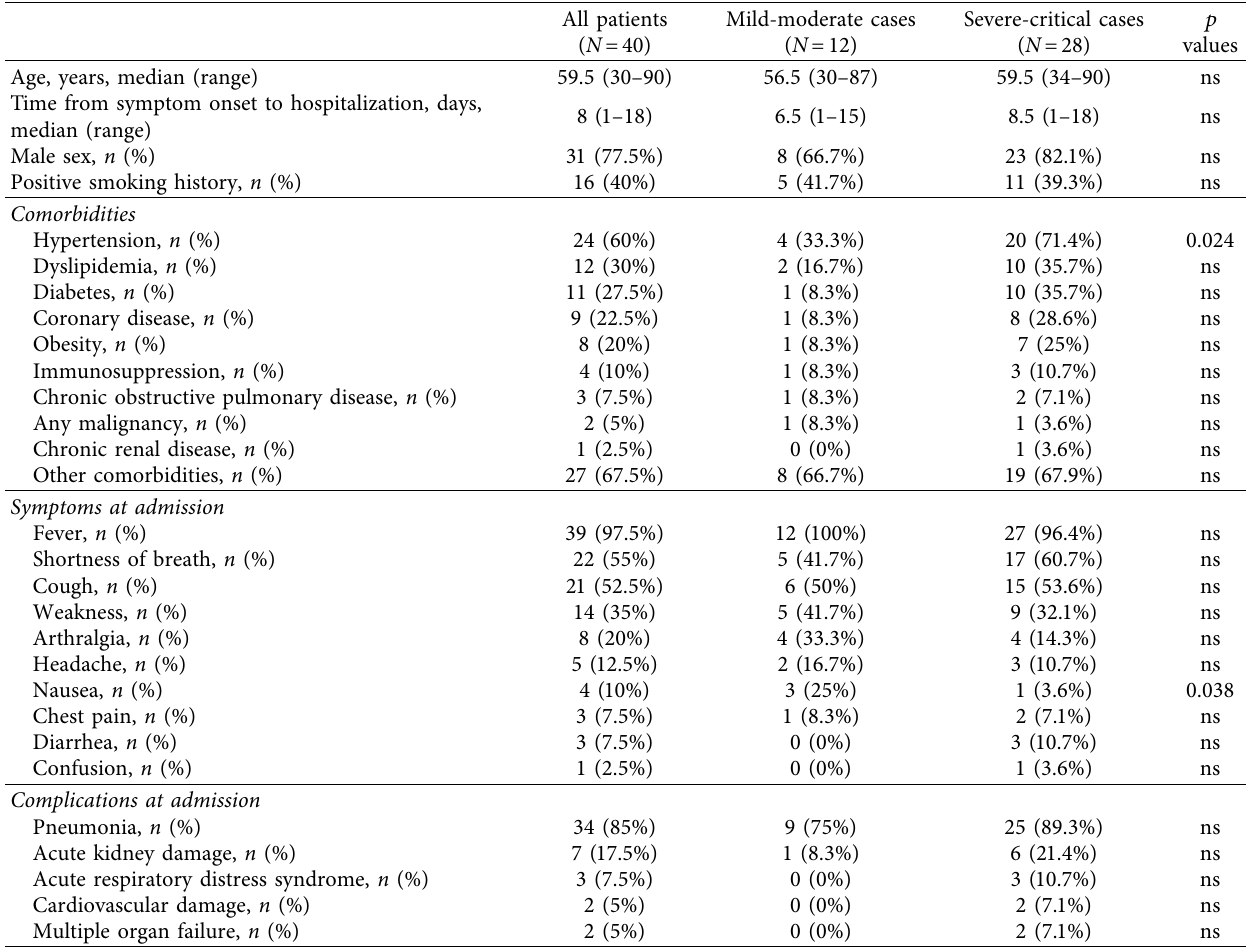
Table 1: Baseline characteristics of the study population.